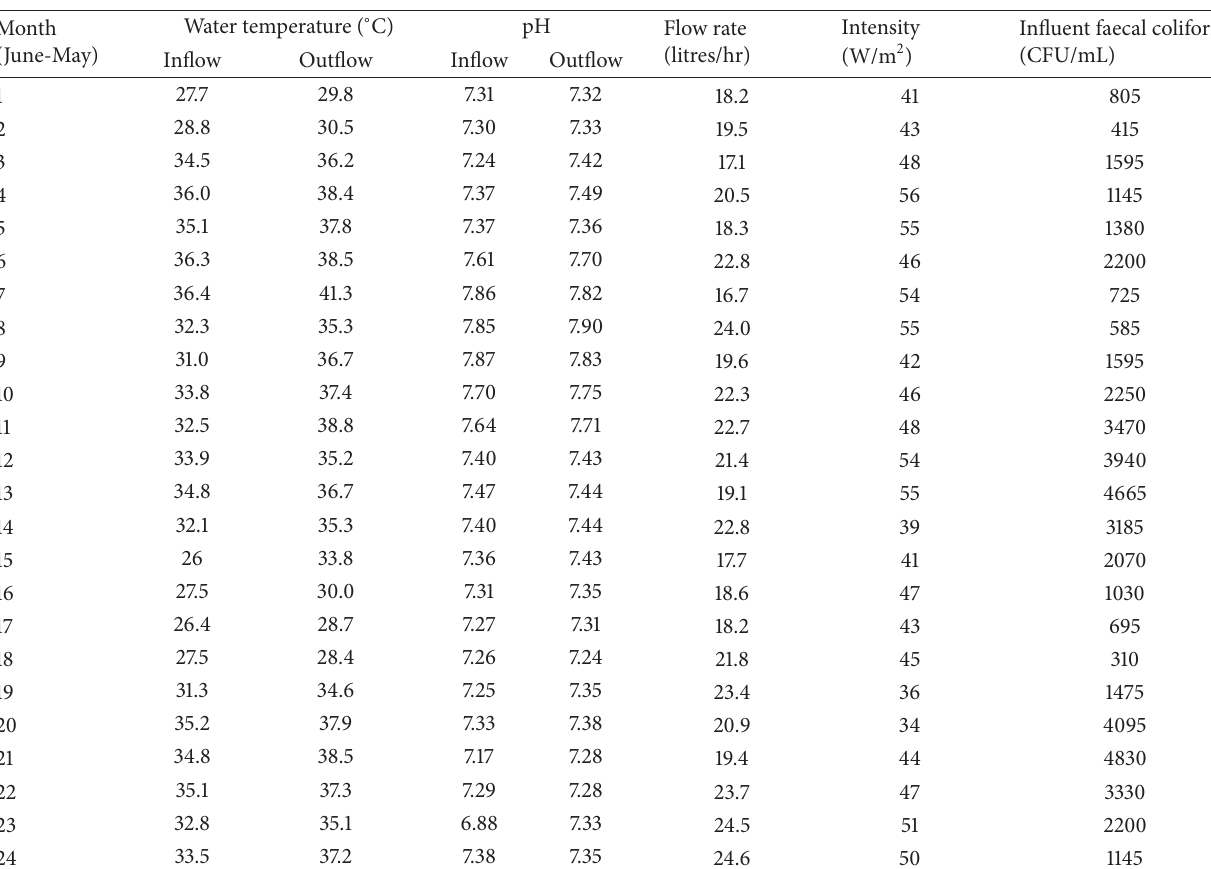
Table 1: Mean water temperatures ( ∘ C), pH, flow rates (litres/hour), daily sunlight exposure time (hours), solar intensity (W/m 2 ), and influent